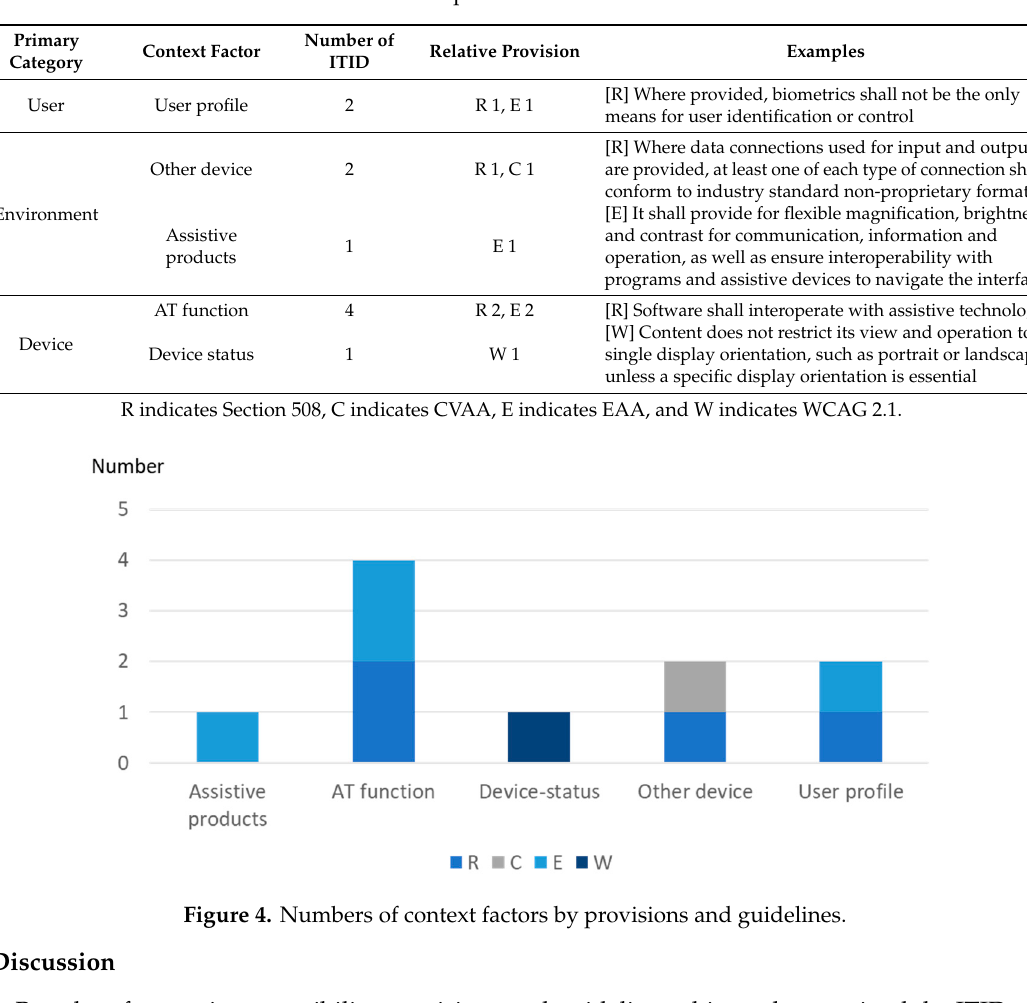
Table 9. Numbers of provisions for each context factor.